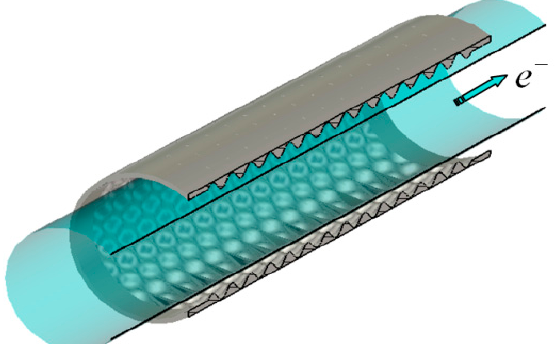
Figure 11. Schematic of a Cherenkov SWO with a tubular REB and cylindrical 2D slow-wave structure realizing the 2D DFB mechanism.